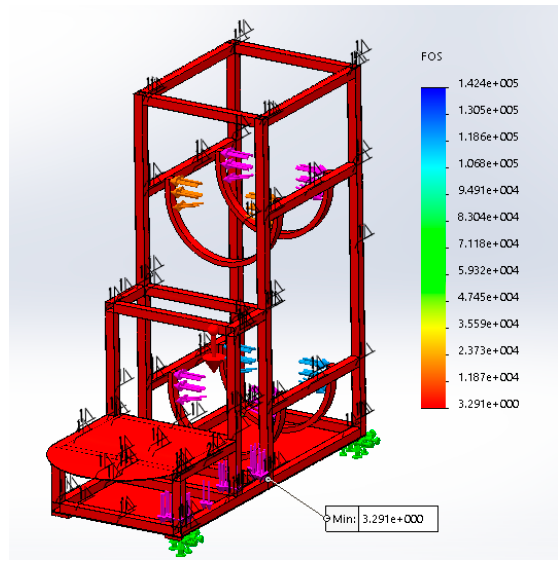
Figure 2. Result of the simulation of the pipe structure with a thickness of 0.5 mm.